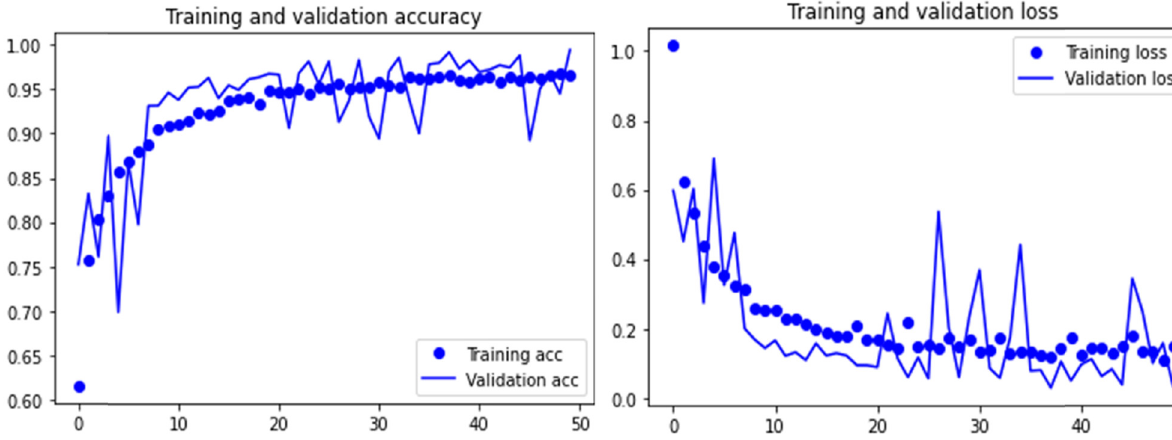
Figure 6: Training and validation on plain dataset [ 37 ] .